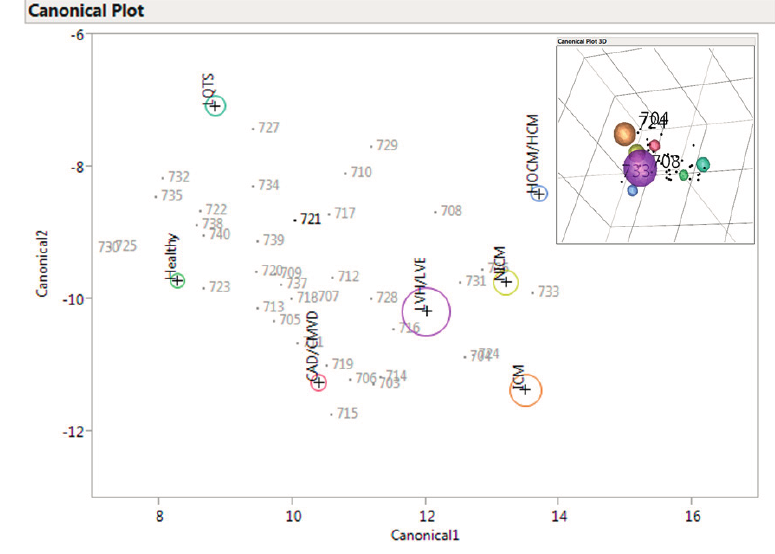
Figure 2. 2D and 3D Linear Discriminant Analysis plot of control ECGs. Each individual control (non-NICM) patient’s A-ECG result as denoted by a number plotted within a 2-dimensional (2D) linear discriminant space. Probability of the presence of a given disease state is grossly demonstrated by the relative proximity of the patient's given number to a given disease state (larger circles), the latter being derived from a pre-existing database of A-ECG information from thousands of earlier patients with known, imaging-proven cardiac health or disease. Note however that because this is a 2D representation of a 3D space (right upper inset), a patient’s number may sometimes have the appearance of proximity to a disease circle in the x and y planes shown, but in the z plane the distance may actually be closer to some other sphere. CAD/CMVD = Coronary Artery Disease and/or Coronary Microvascular Disease Population; LVH/LVE = Left Ventricular Hypertrophy or Enlargement population; HOCM/HCM = Hypertrophic Cardiomyopathy population; NICM = Non-Ischemic Cardiomyopathy population; ICM = Ischemic Cardiomyopathy population; and LQTS = Long QT Syndrome (LQTS) population,